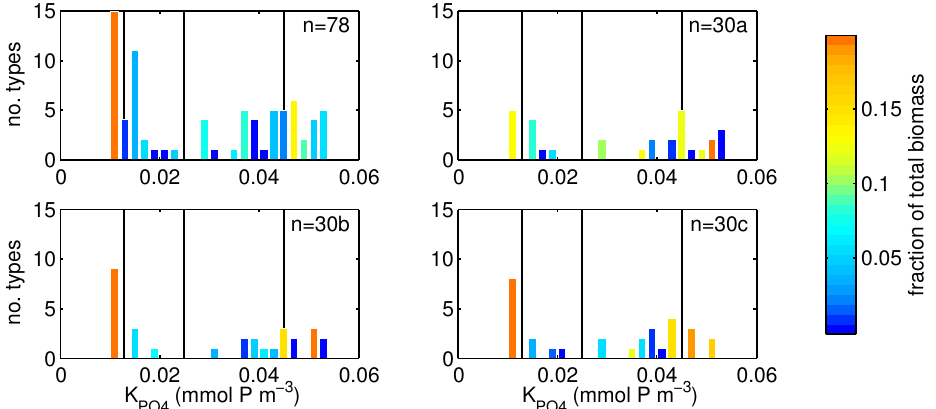
Figure 5. Histogram of the number of phytoplankton subtypes against half-saturation concentration for phosphate uptake ( K PO simulation with n = 78 types (a) and the three simulations with n = 30 types (b–d) . Colour shading indicates the fraction of total biomass for all subtypes within a K PO bin. Vertical lines indicate the PFTs in the n = 4 and n = 3 simulations (see Fig. 4 for 4